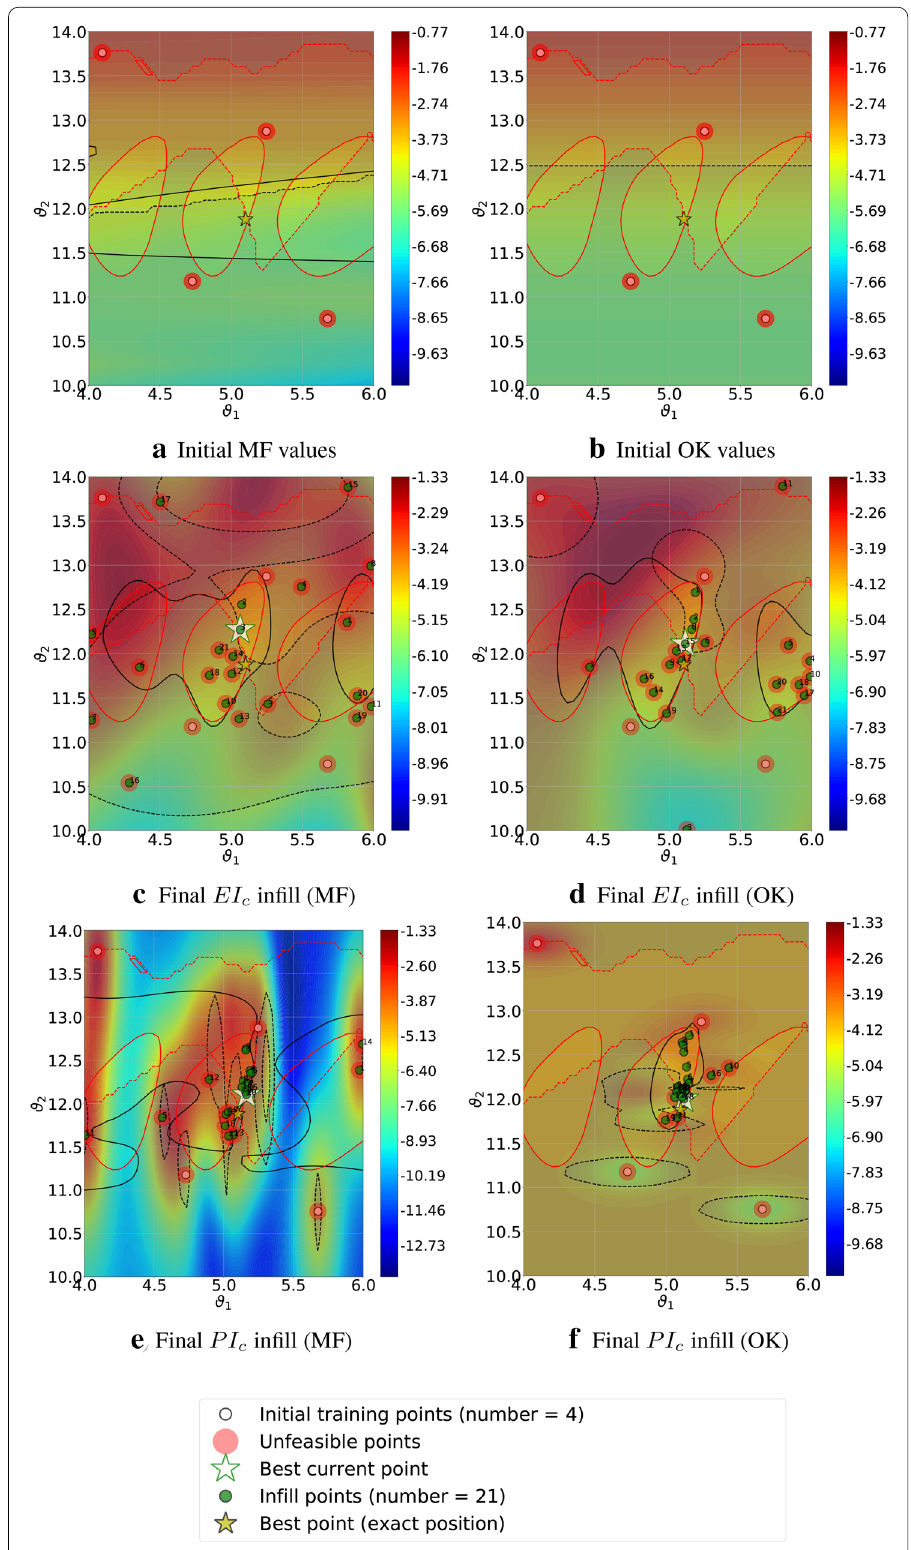
Fig. 9 Optimization results obtained using the EI c · and PI c Starting from 4 points (first row), the algorithm is iterated for 21 iterations. The first column corresponds to results using the MF model, and the second column results using the OK